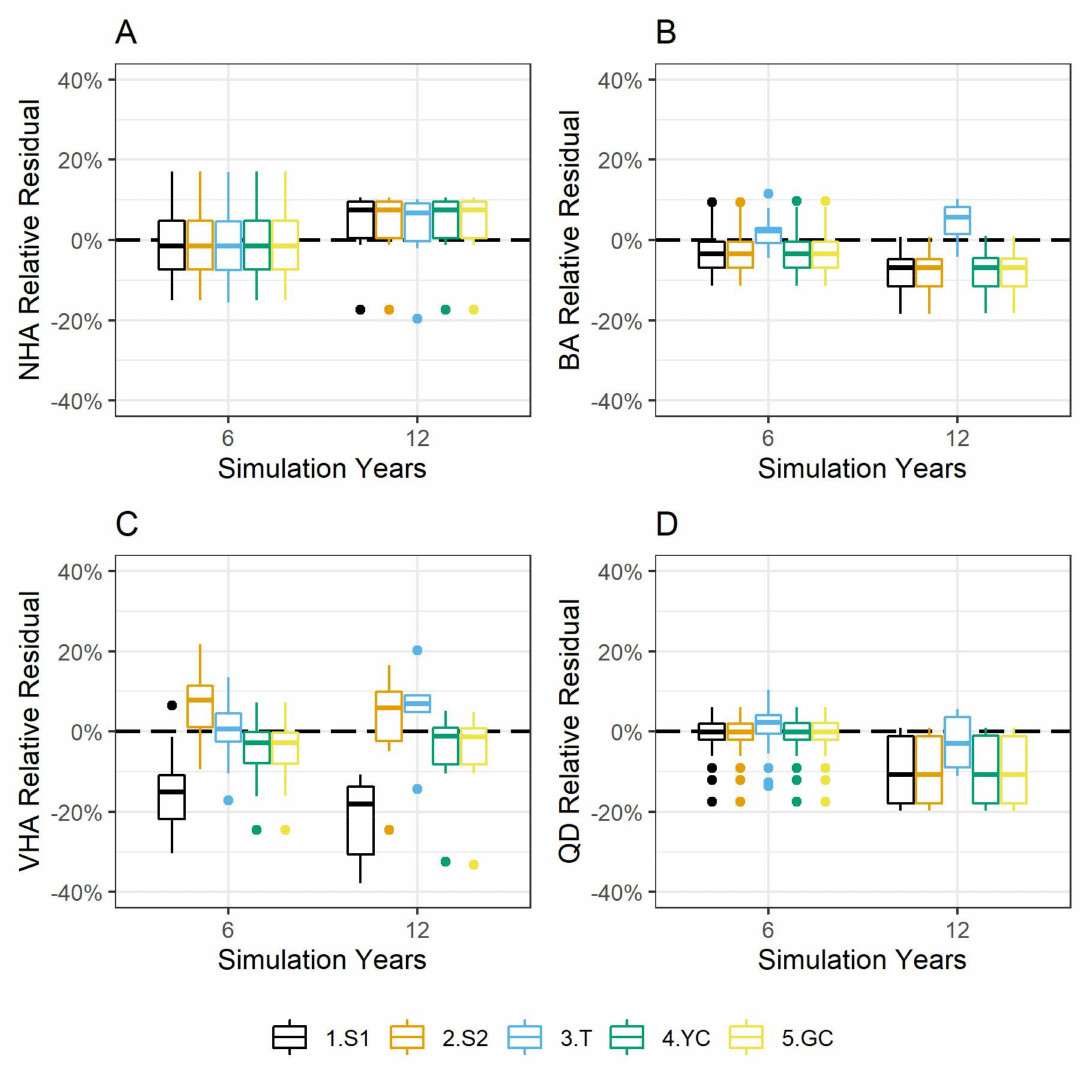
Figure 2. Stand parameters for each simulation (S1, S2, T, YC, and GC, see text for definitions). ( A ): number of trees (NHA, trees ha − 1 ), ( B ): basal area (BA, m 2 ha − 1 ), ( C ): stand volume (VHA, m 3 ha − 1 ), and ( D ): quadratic diameter (QD, cm). Statistics are presented as box plots of relative residuals at 6 and 12 years of projection in second-growth RORACO forests in southern